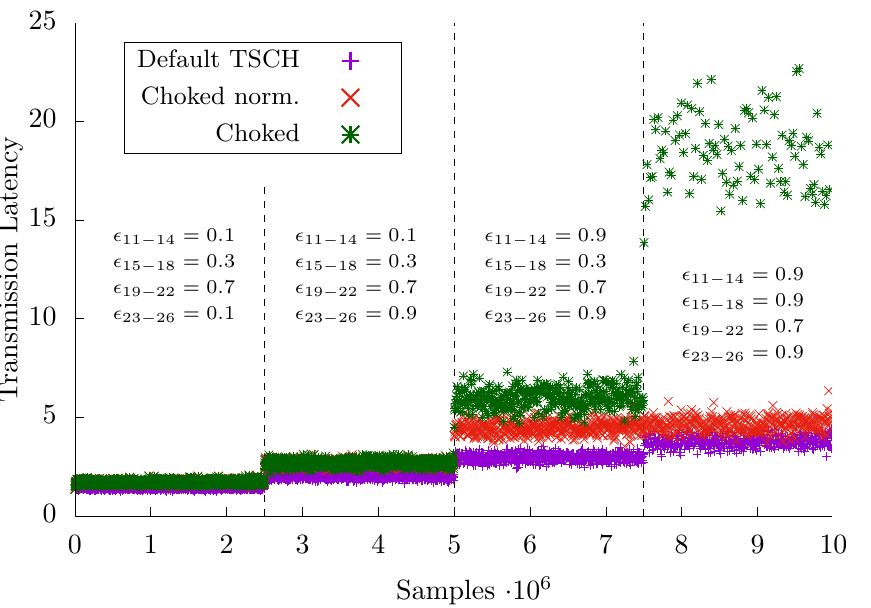
Figure 6. Frame transmission latency vs. time